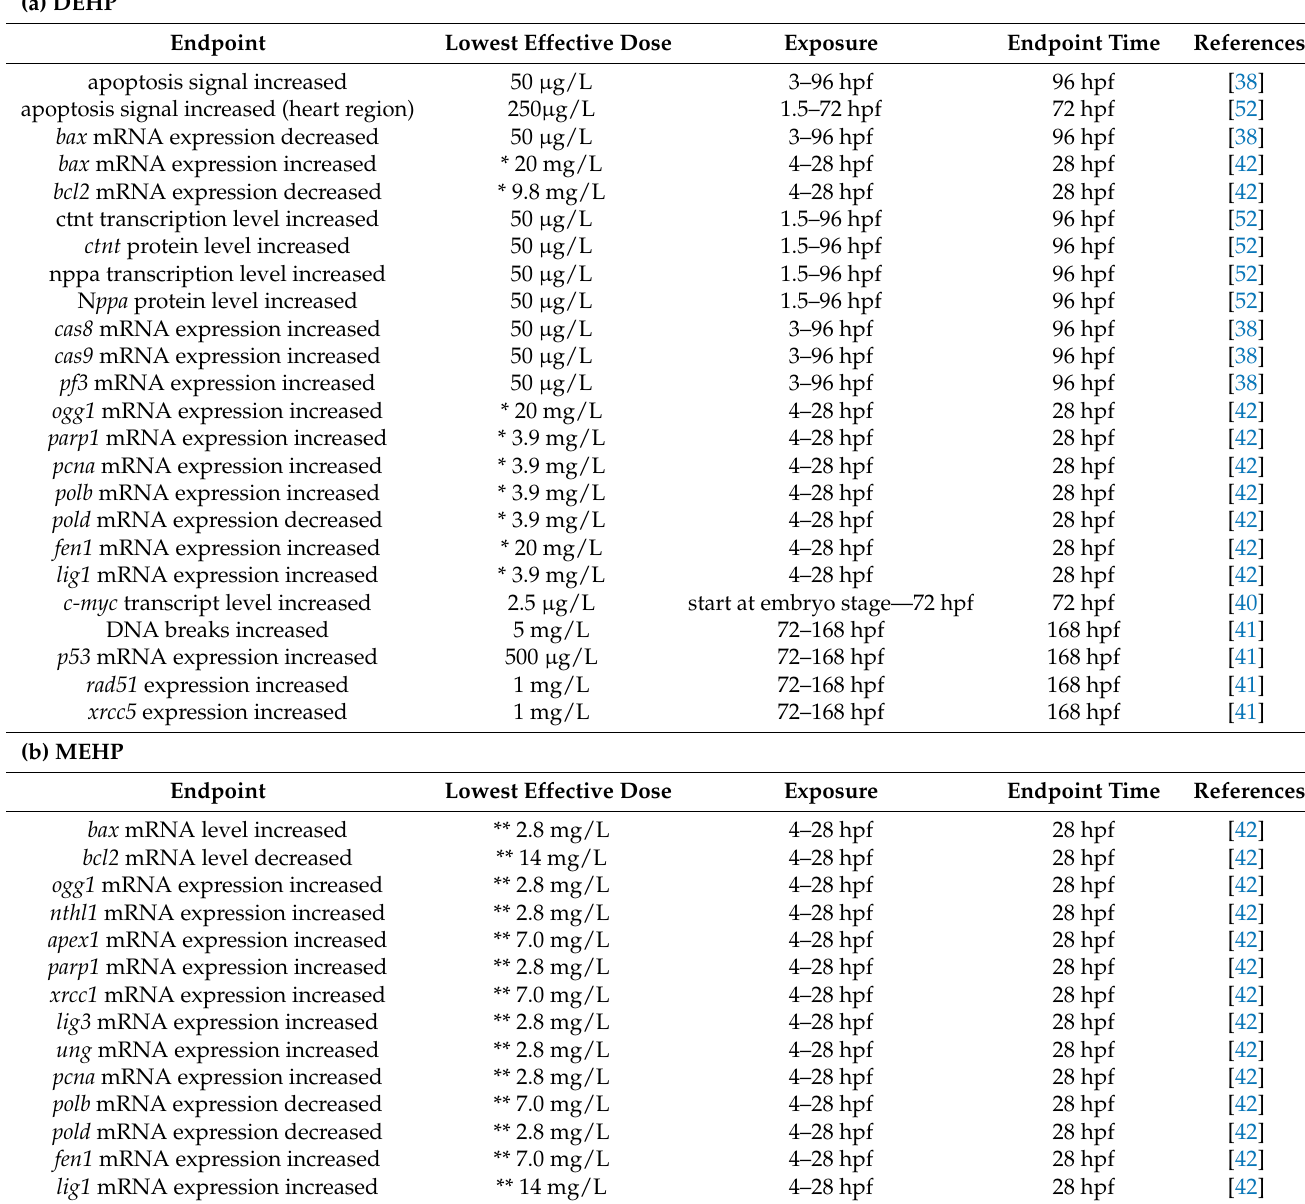
Table 8. Apoptosis and genotoxicity from acute exposures to (a) DEHP and (b) MEHP on zebrafish embryos. * The concentration was converted from nM or µ M using the molar mass of DEHP 390.57 g/mol. ** The concentration was converted from nM or µ M using the molar mass of MEHP 278.34